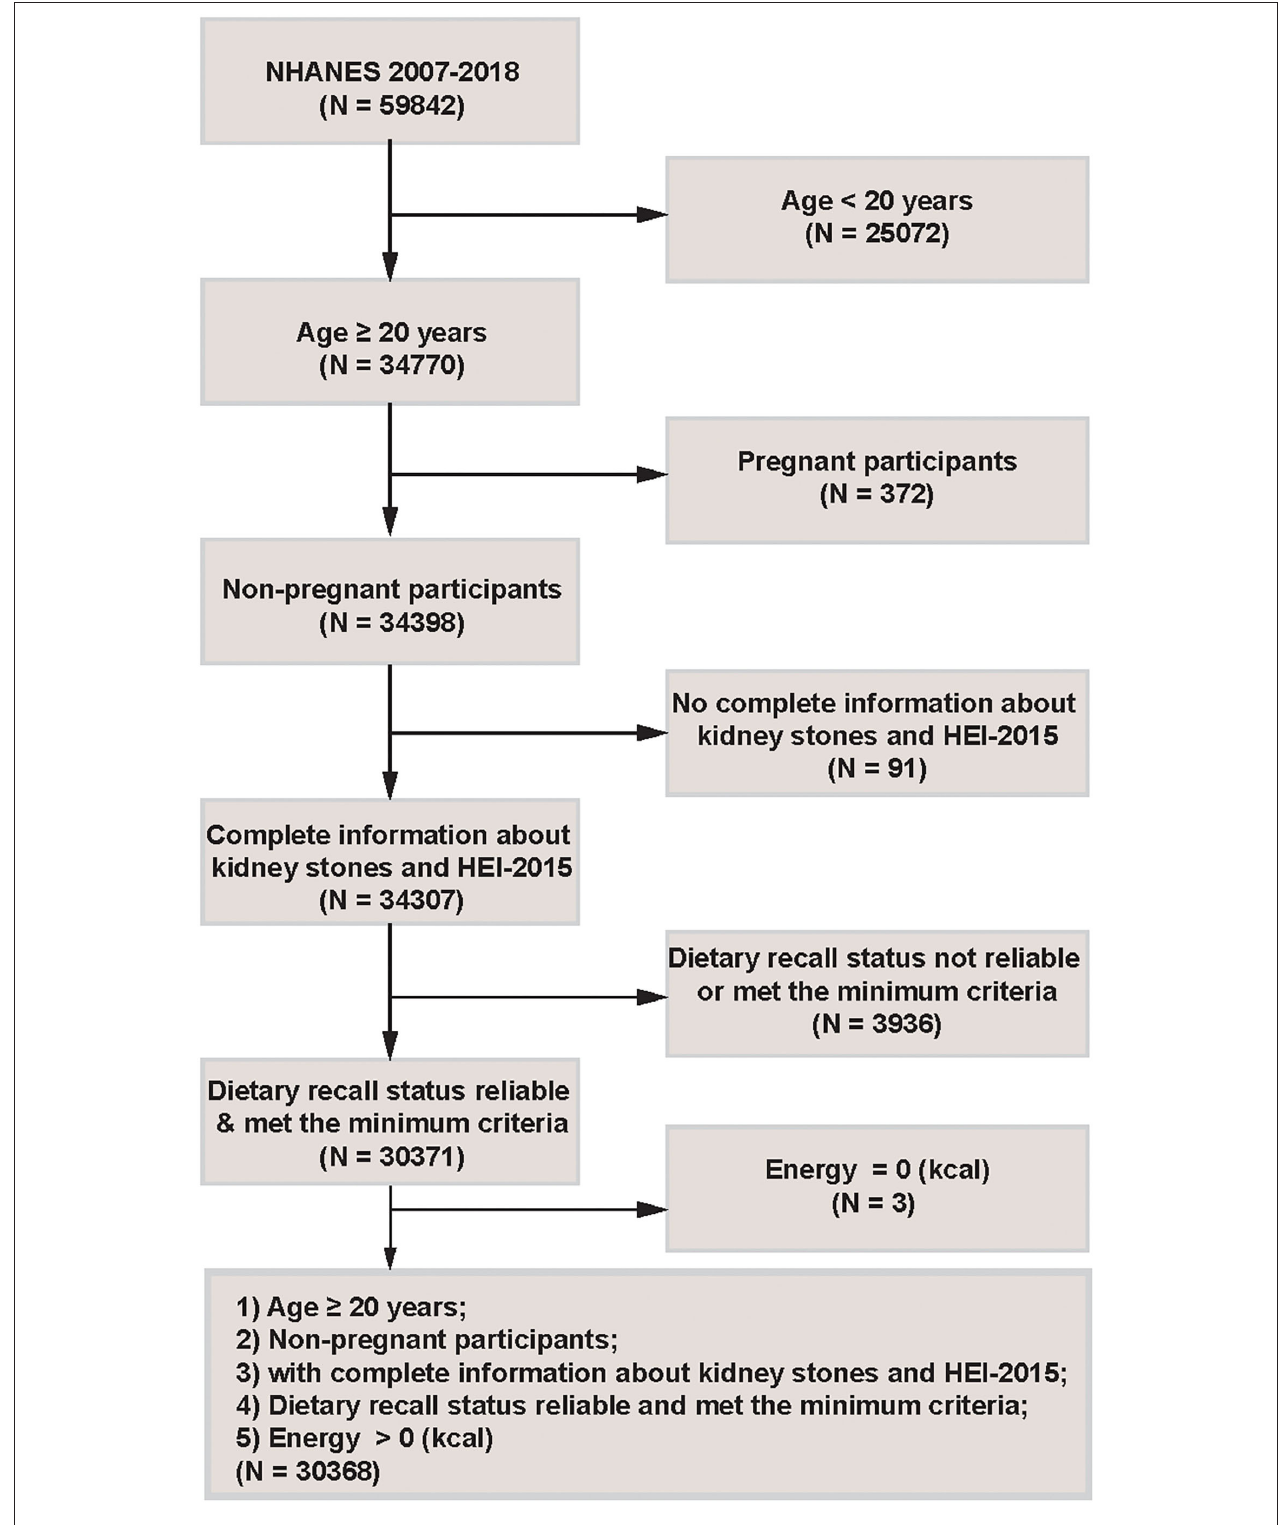
FIGURE 1 | Flowchart of the study